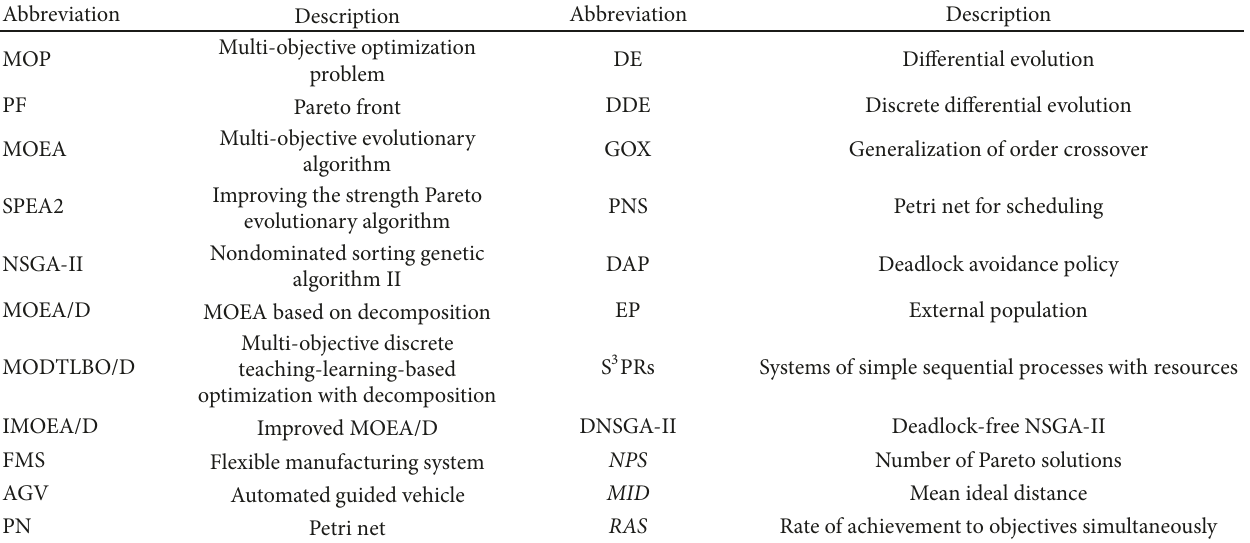
Table 1: Descriptions of